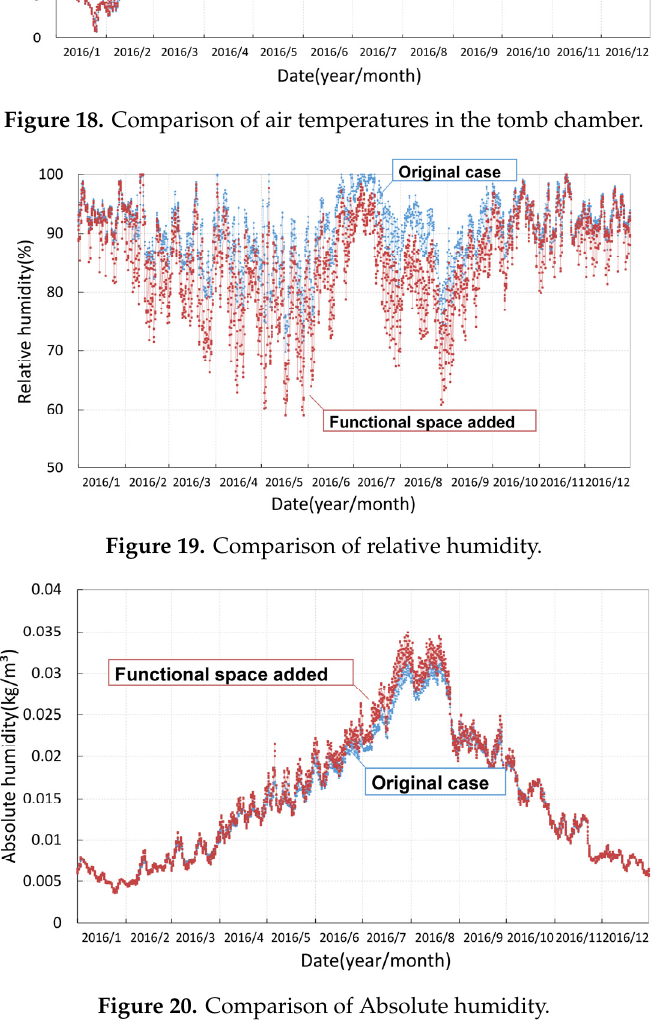
Figure 20. Comparison of Absolute humidity. Figure 19. Comparison of relative humidity. Table 5. Statistics of absolute humidity in the tomb chamber. Table 4. Statistics of relative humidity in the tomb chamber.